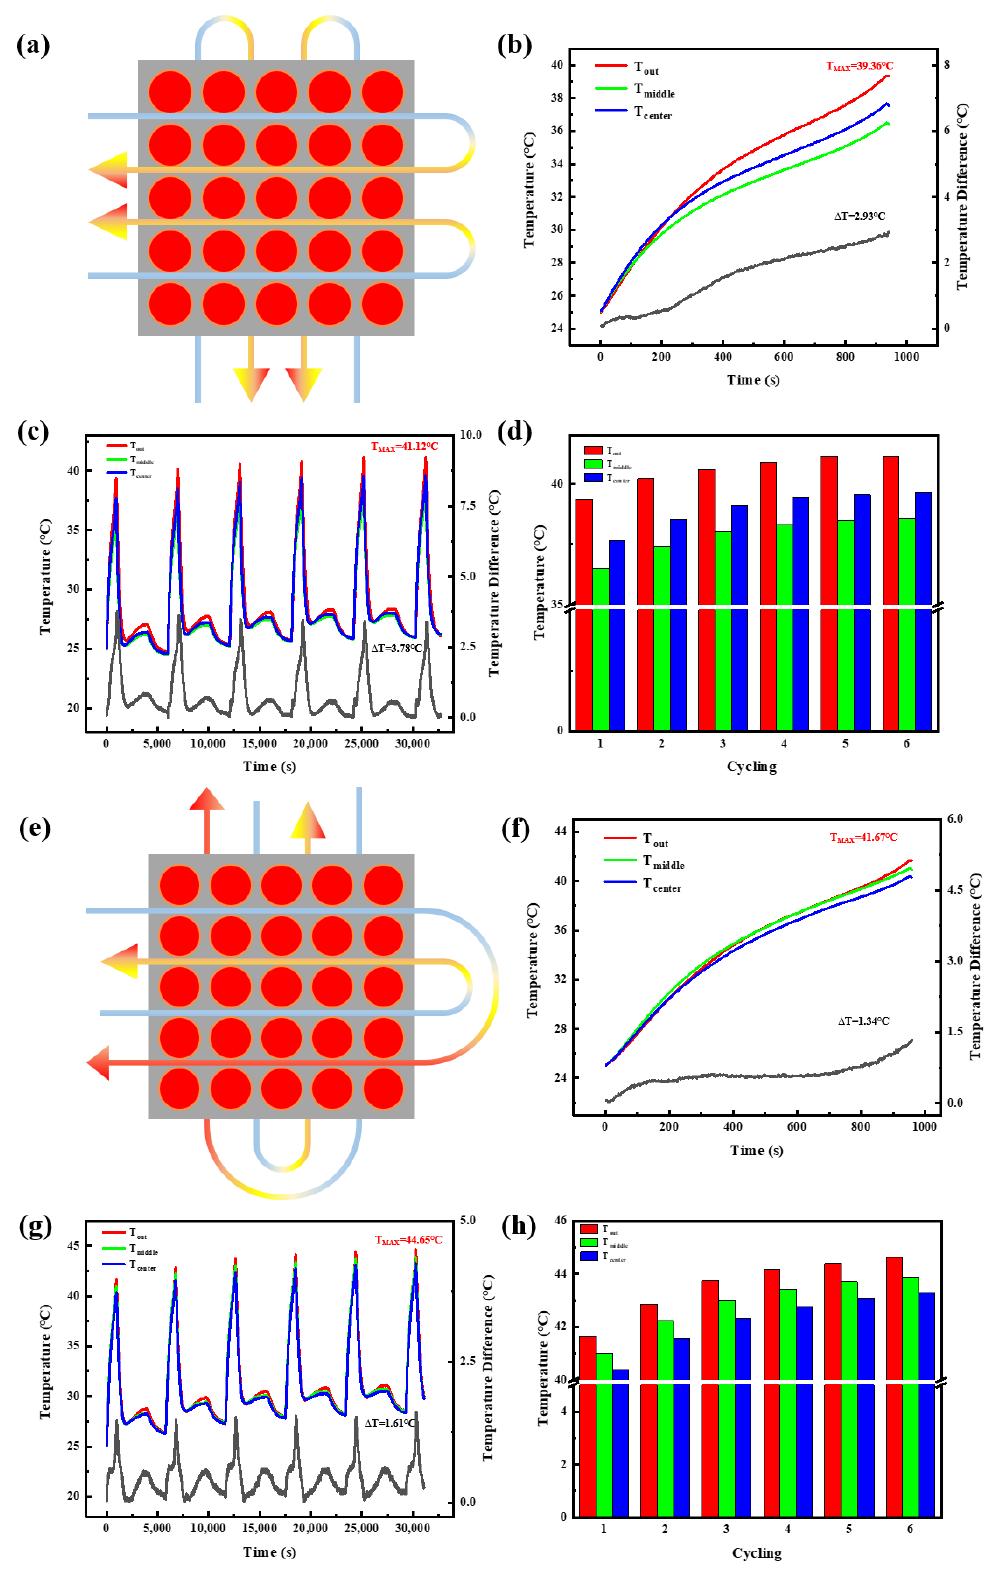
Figure 9. Temperature variation of CSG–LC module of ( a , e ) Channel SMC, ( c , g ) Channel RCC at cycling test, maximum temperature of T 1 , T 2 and T center of ( b , f ) Channel SMC, ( d , h ) Channel RCC at the end of each cycle.